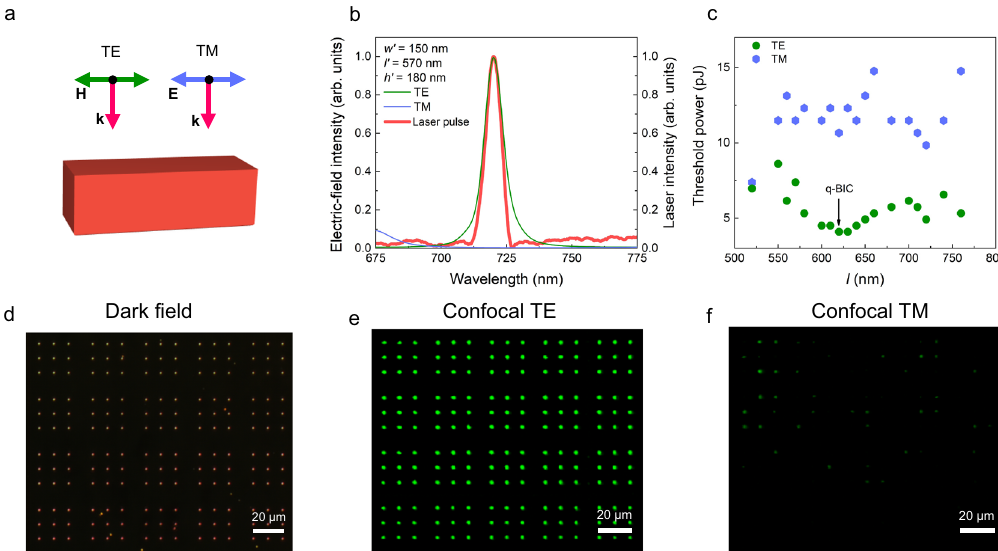
Fig. 5 Polarization dependent threshold for the luminescence burst. a Schematic illustrating the excitation of a Si/SiO 2 cuboid with transverse electric (TE) and transverse magnetic (TM) polarized laser light. b Two-photon-induced absorption (TPA) ( 1 V with l ’ = 570 nm and w ’ = 150 nm. Also shown is the spectrum of a femtosecond laser pulse with a duration of 130 fs at 720 nm. c Thresholds for the luminescence burst measured Si/SiO 2 cuboids with different lengths excited by using TE- and TM-polarized laser light. d Dark- fi eld image of a regular array of Si/SiO 2 cuboids. e Luminescence from the regular array of Si/SiO 2 cuboids shown in d observed by using a laser scanning confocal microscope with TE- polarized laser light at 720 nm as the excitation source. The luminescence observed by using TM-polarized laser light is shown in f